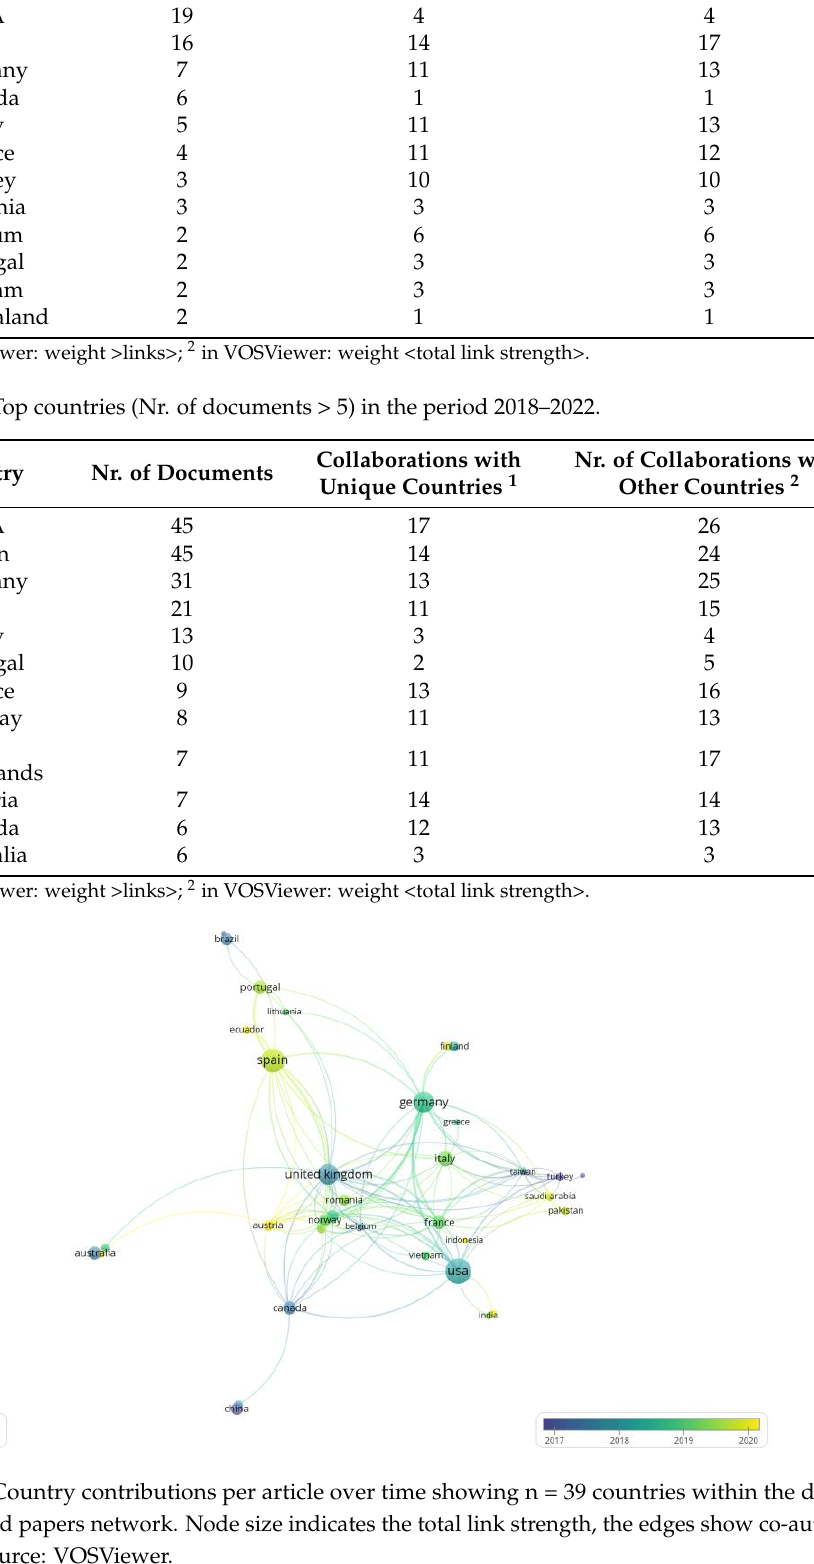
Table 10. Top countries (Nr. of documents > 2) in the period 2013–2017. Country Nr. of Documents Country Nr. of Documents